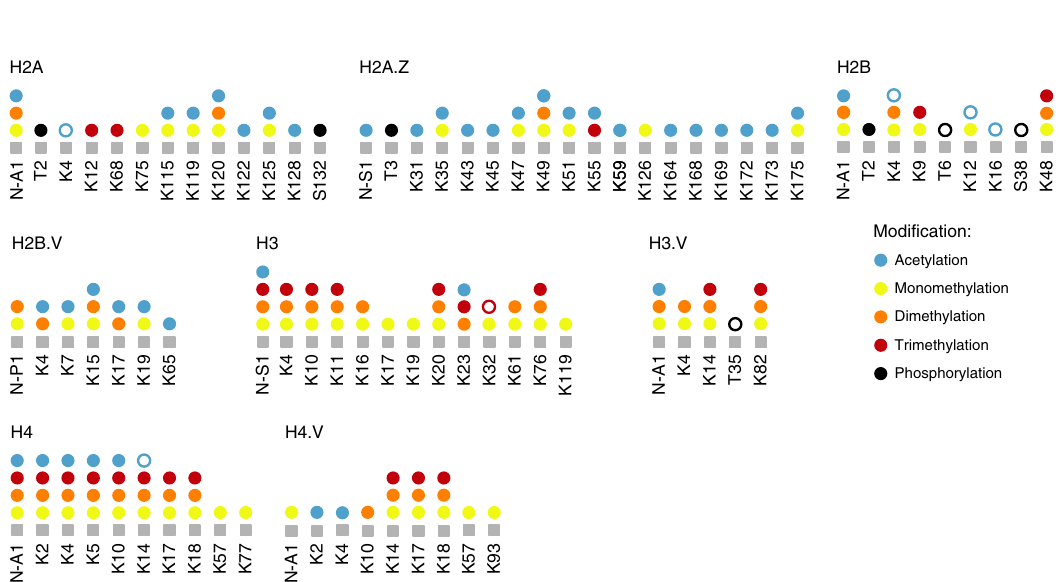
Fig. 4 Summary of all acetylation, methylation and phosphorylation marks identi fi ed on T. brucei histones. PTMs detected in this study using acid extraction of histones from mononucleosomes or locus-speci fi c histone isolation are indicated by solid circles. PTMs detected previously 22 – 25 but not in our study are indicated by empty circles. Supplementary Data 1 contains information on how often a speci fi c PTM was detected and Supplementary Fig. 7 spectra of the newly identi fi ed phosphor marks. Source data are provided as a Source Data fi indicated that all three TSS-speci fi c acetyl marks (H4K2, H4K5